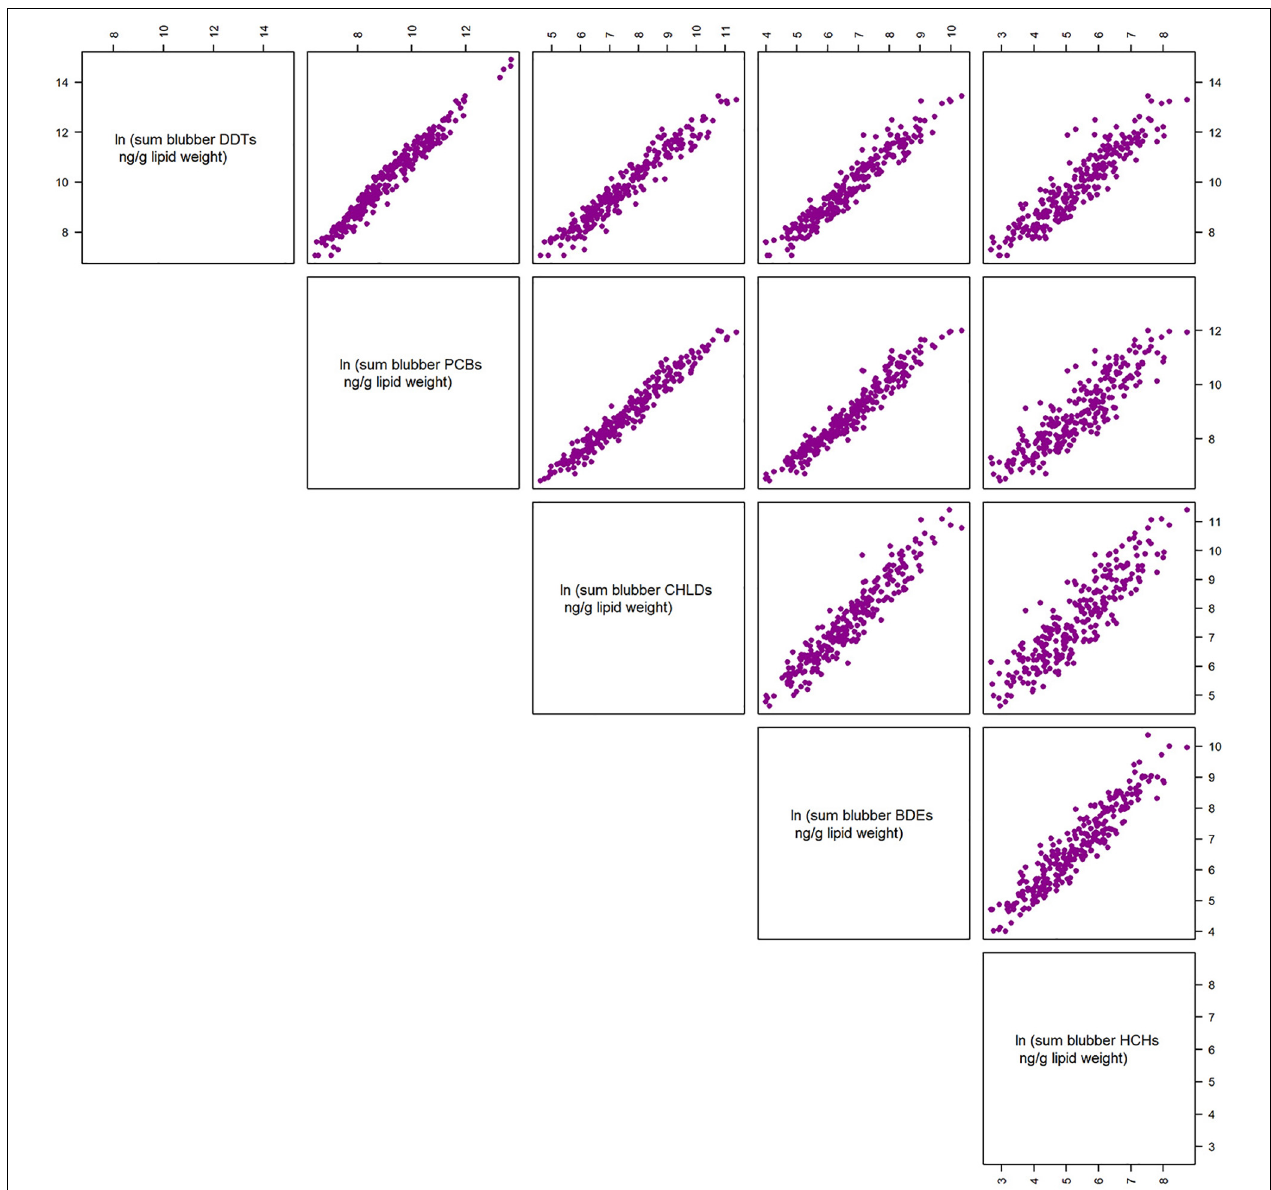
FIGURE 2 | Relationship between blubber concentrations in different contaminant classes (log e transformed, lipid weight, ng g − 1 ). DDTs, Dichlorodiphenyltrichloroethanes; PCBs, polychlorinated biphenyls; CHLDs, chlordanes; BDEs, polybrominated diphenyl ethers; HCHs, hexachlorocyclohexanes.